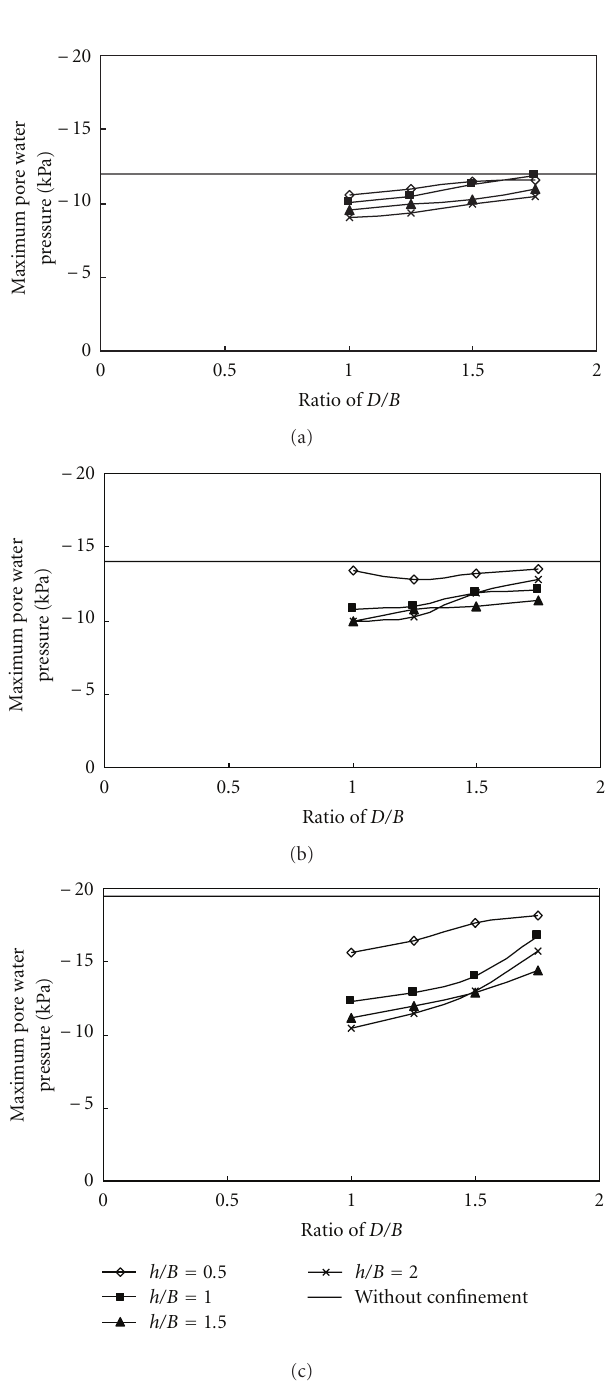
Figure 6: The relation between induced maximum pore water pressure and cell geometry at di ff erent